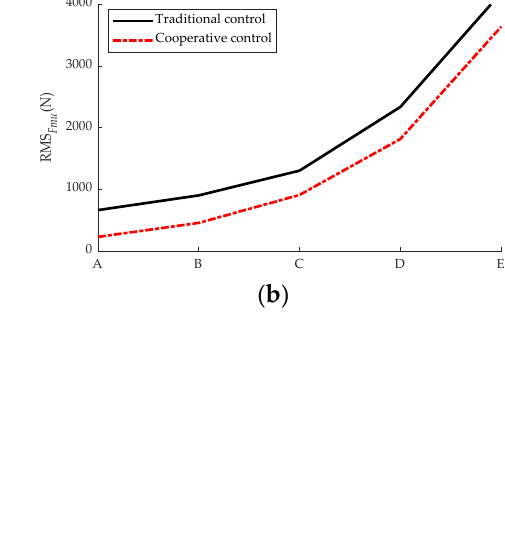
Figure 8. Performance comparisons between traditional and cooperative control at 30 m · s − 1 .